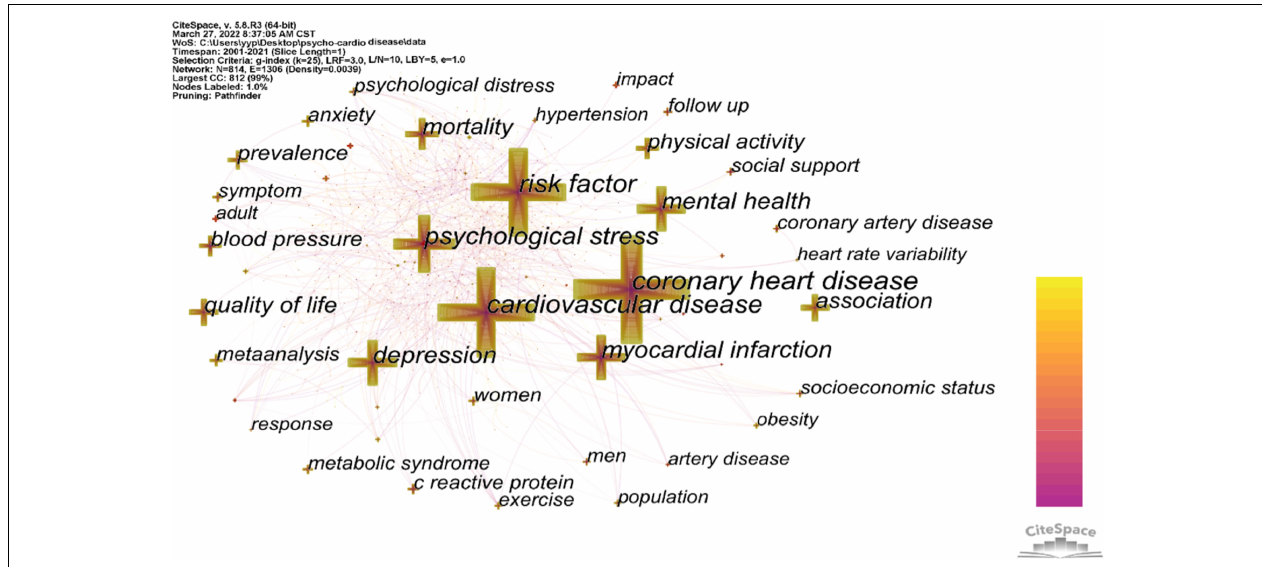
FIGURE 4 | Network of the keywords in publications about the psycho-cardiological disease and related literature.